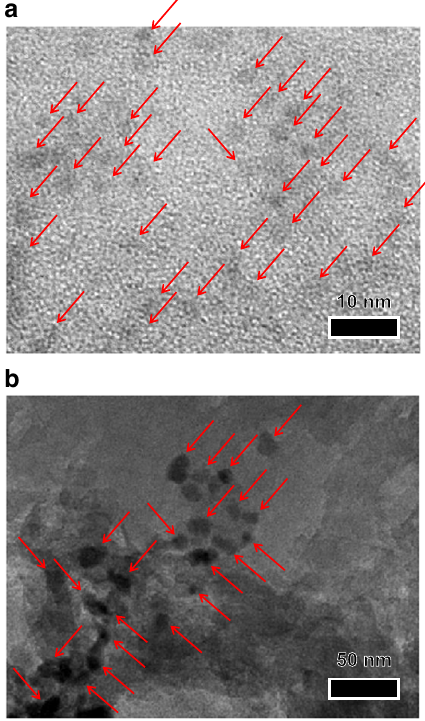
Fig. 2 Typical TEM images. a GQD solution. b GQD 1 /g-C 3 N 4 catalyst. The red arrows are the guide for the eyes to follow the GQD particles.